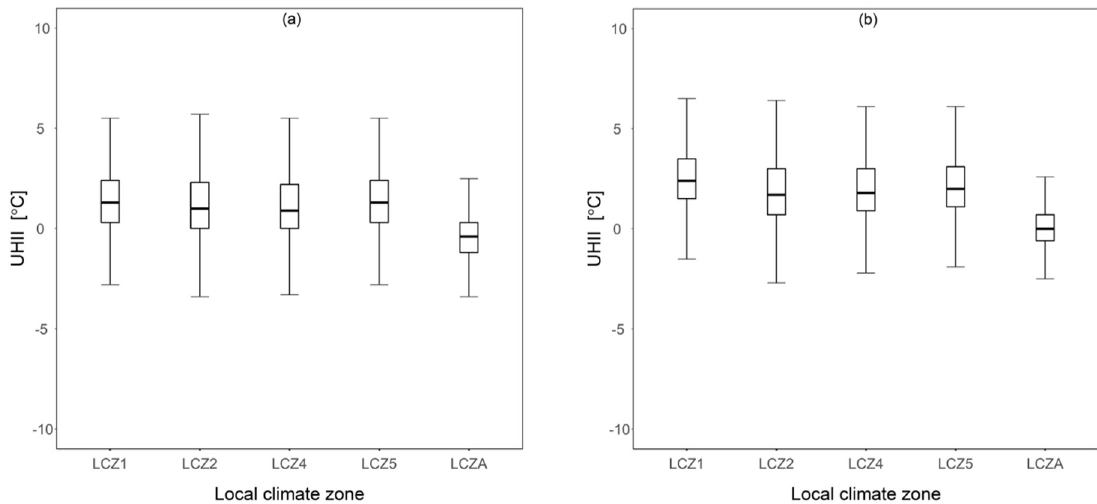
Fig 8. Mean UHII values under different LCZs. (a) 2012 (b) 2016.